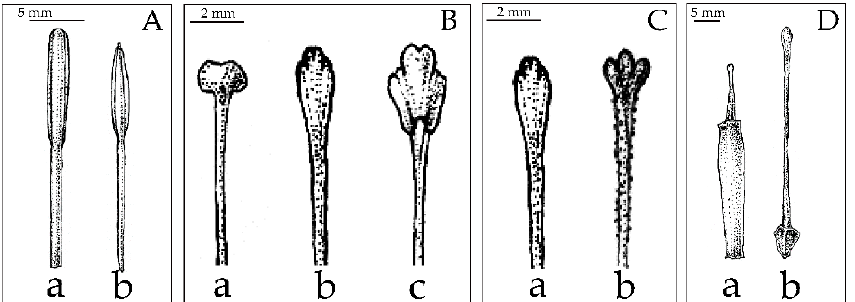
Figure 10. Stamen and pistil morphologies comparison and character state between Musaceae (char- acter no. 17–21), ( A ): shape of anther: ( a ) oblong; ( b ) ensiform, ( B ) shape of stigma: ( a ) capitate; ( b ) clavate; ( c ) spatulate, ( C ) wart-like structure present on style surface: ( a ) absent; ( b ) present, ( D )shape: ( a ) cylindrical; ( b ) angular.